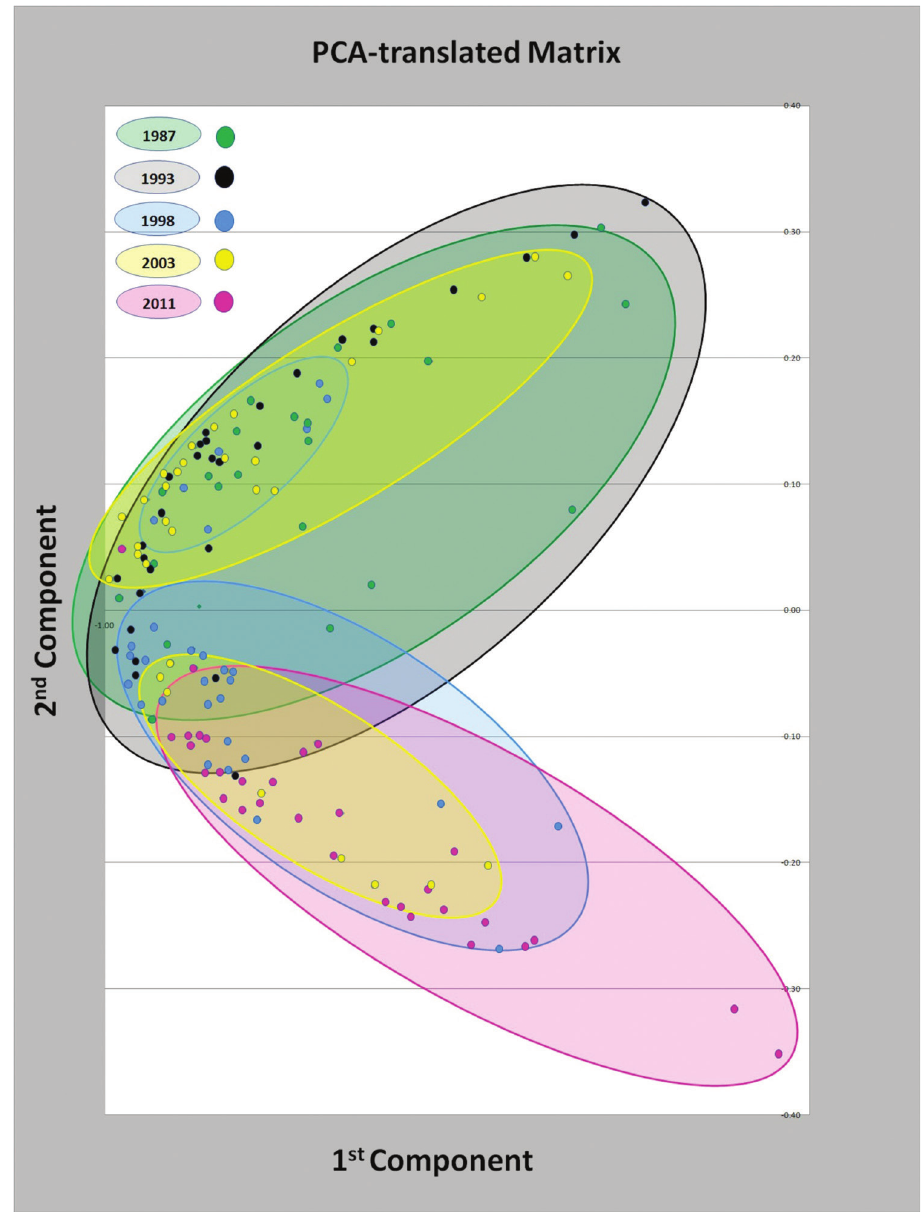
Figure 9. Transposed PCA bi-plot of the first two components during the whole 1987–2011 period. The separation or overlapping of the different years are highlighted by different